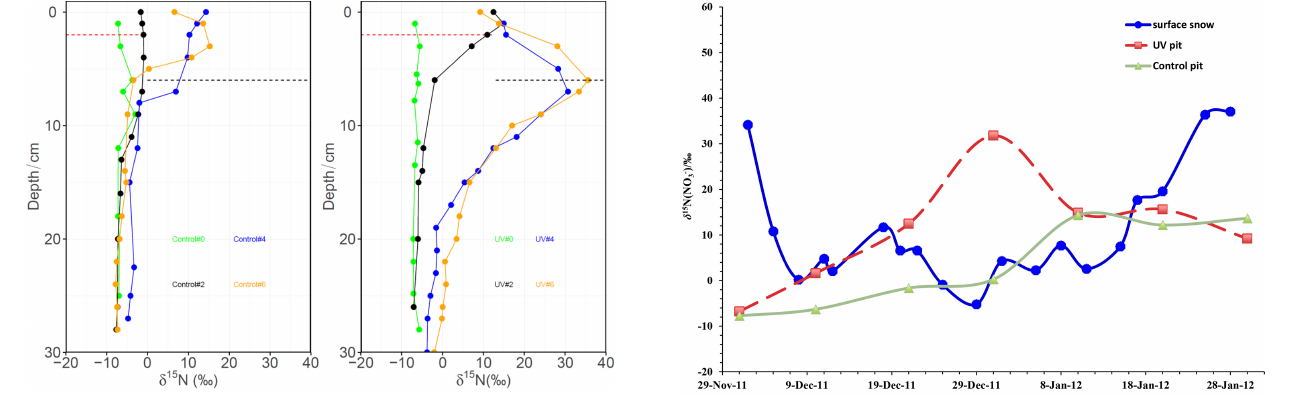
Figure 5. δ 15 N depth profiles for snow nitrate in the control (left panel) and UV (right panel) pits. The horizontal lines show the depth where mixing is present in samplings nos. 0–2 (red) and 4–6 (black) in both pits.